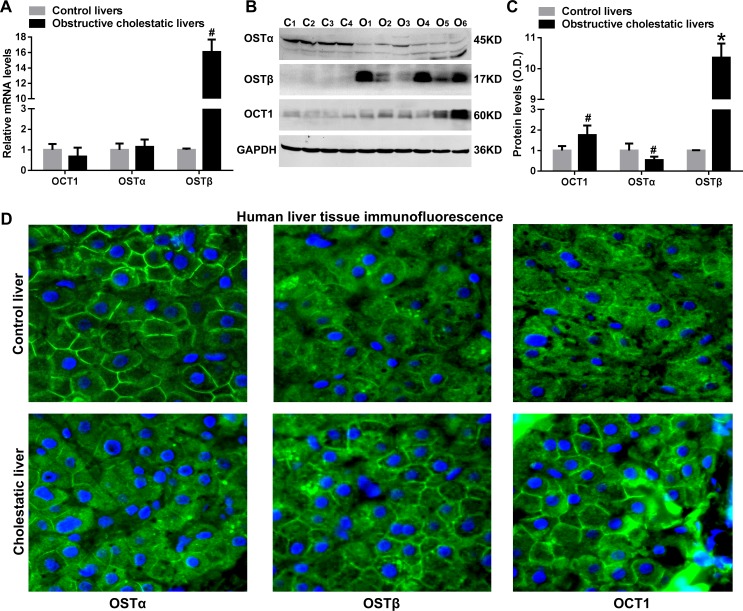
OSTα/β and OCT1 levels at the basolateral membrane of cholestatic hepatocytes of patients.(A) Real-time qPCR analysis of mRNA levels of efflux transporters OSTα, OSTβ and OCT1 in liver samples of patients with obstructive cholestasis. (B) Representative western blots for OSTα, OSTβ and OCT1 and (C) corresponding densitometry (n = 22 for each group). (D) IF labeling of OSTα, OSTβ and OCT1 protein (green) in the liver of patients with obstructive cholestasis and controls. Nuclei of hepatocytes from liver samples were stained with DAPI (blue). C, controls; O, obstructive cholestasis liver samples. *p < 0.01; #
p <0.05 versus controls. DAPI, 4′, 6-diamidino-2-phenylindole.